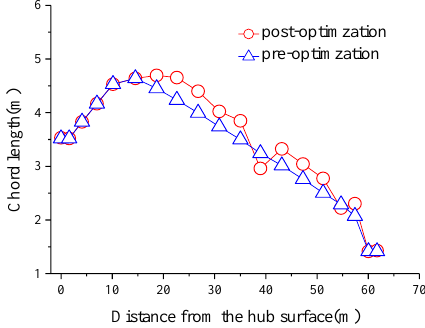
Figure 14. Distribution of the chord length at rated wind speed before and after optimization.